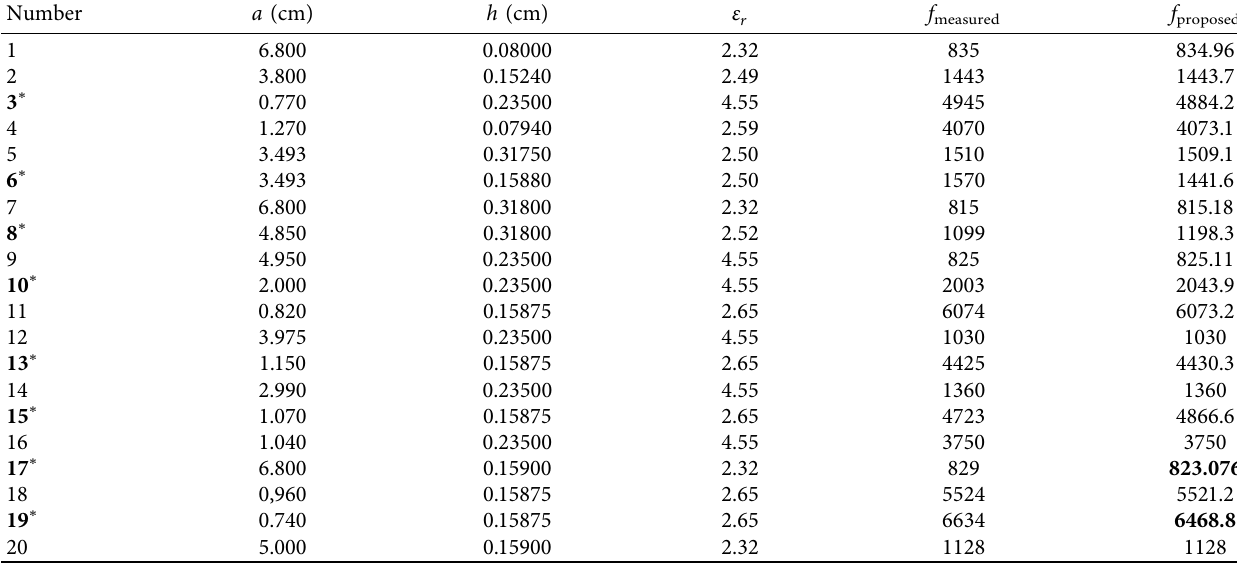
Table 4: Resonant frequency of circular MSA in TM